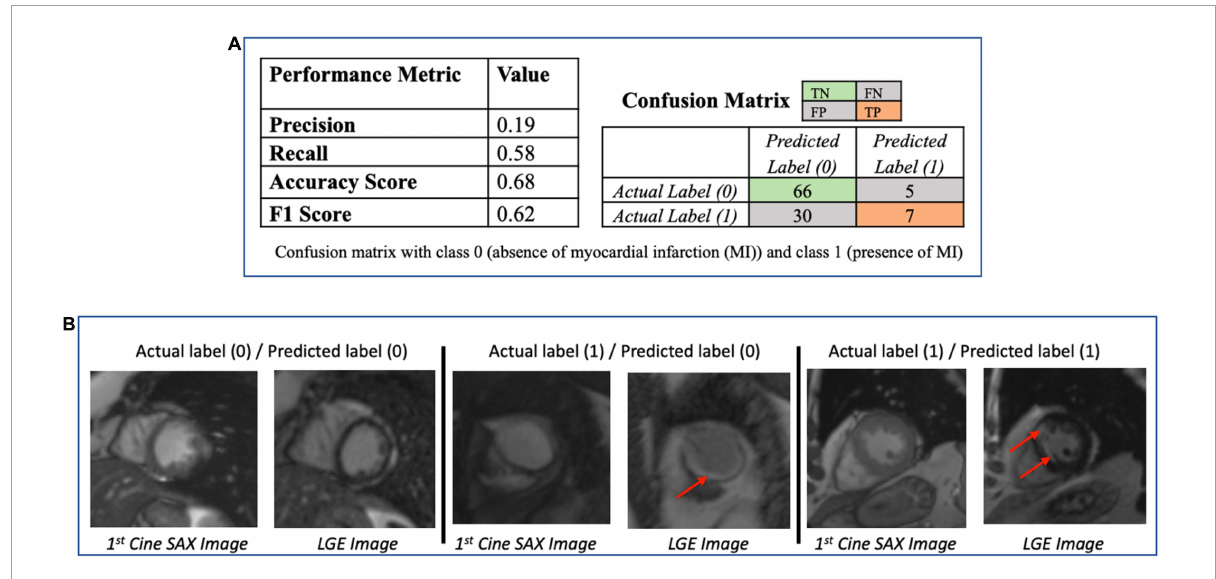
FIGURE8 (A) Performance of the ResNet50 classification model (to determine presence/absence of myocardial scar) using the test dataset ( N = 108). The low value of the precision score (0.19) makes the model unsatisfactory in determining the presence of absence of myocardial infarction. (B) Some examples of the prediction of the ResNet50 classification model. The red arrows point to the location of the scar. The middle column shows the case that the classification models got wrong.